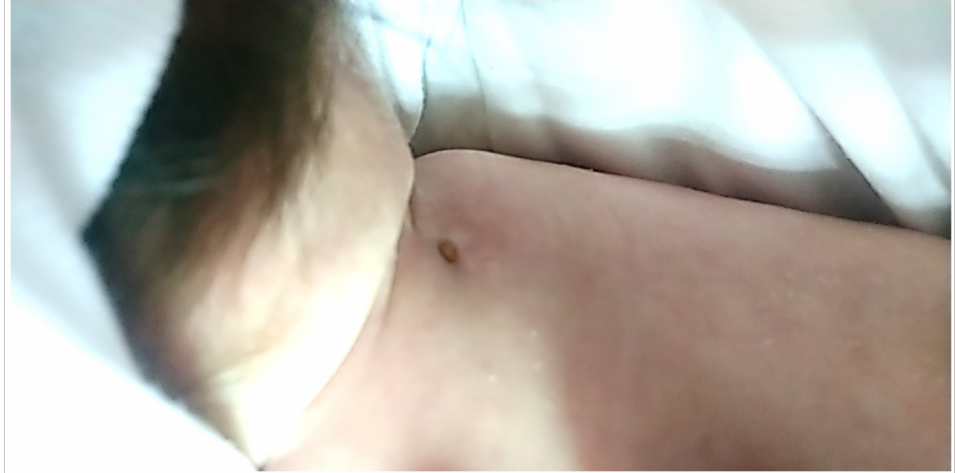
Figure 1. Neck abscess during healing.